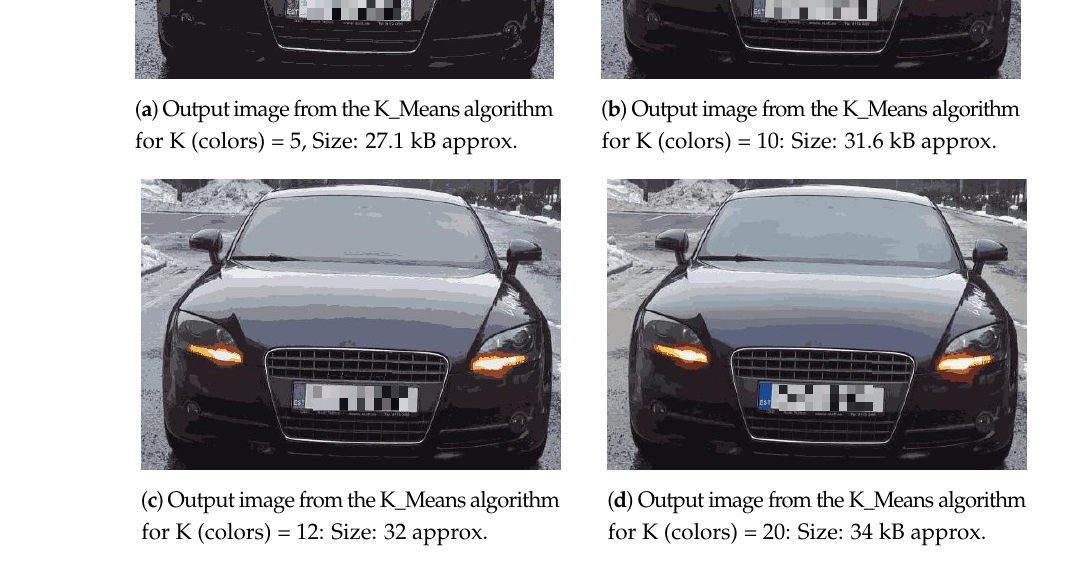
Figure 11. Output of the K_Means algorithm for an input image with a resolution of 513 × 355 pixels, total number of pixels = 182,115, total number of unique colors = 25,512 and an input size = 66.97 kB. ( a ) K = 5, ( b ) K = 10, ( c ) K = 12, and ( d ) K = 20. Note: the number plate in each output image